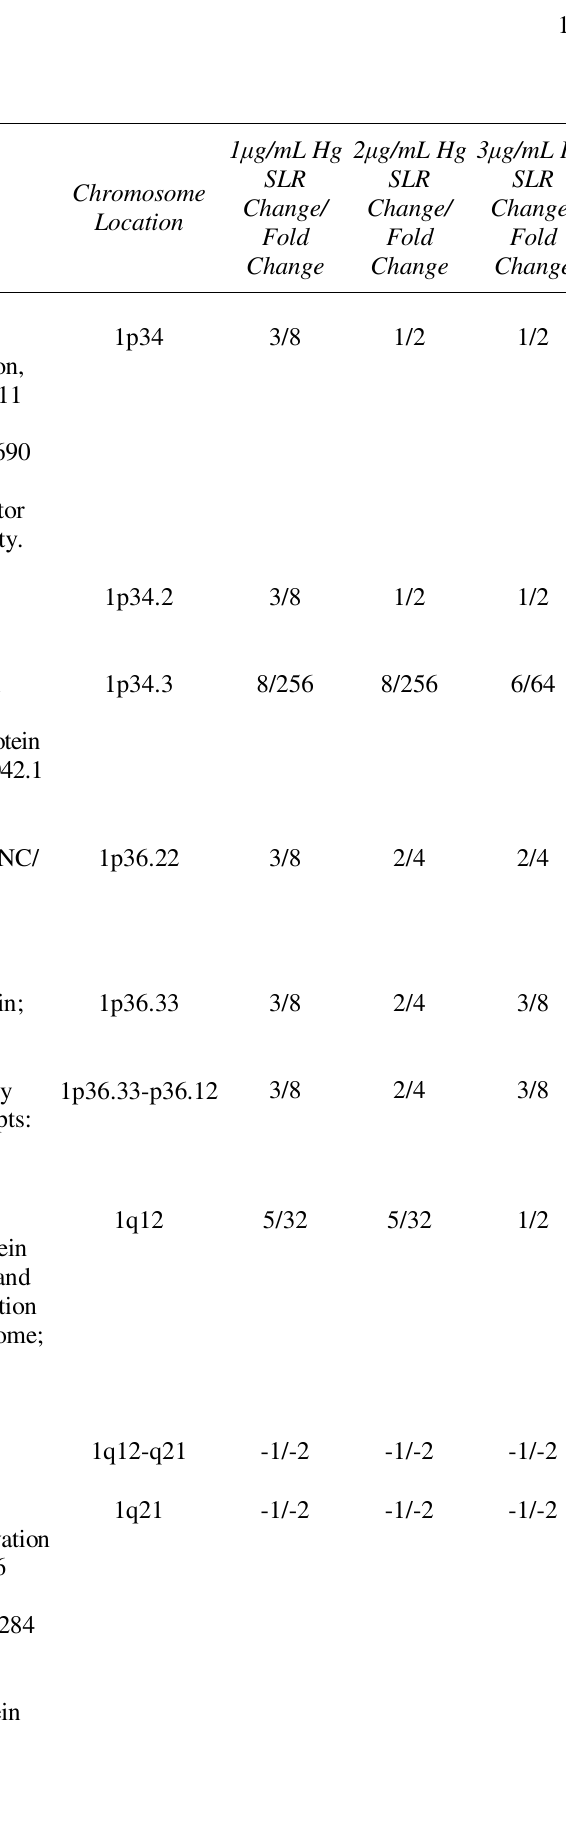
SLR-- signal log ratios